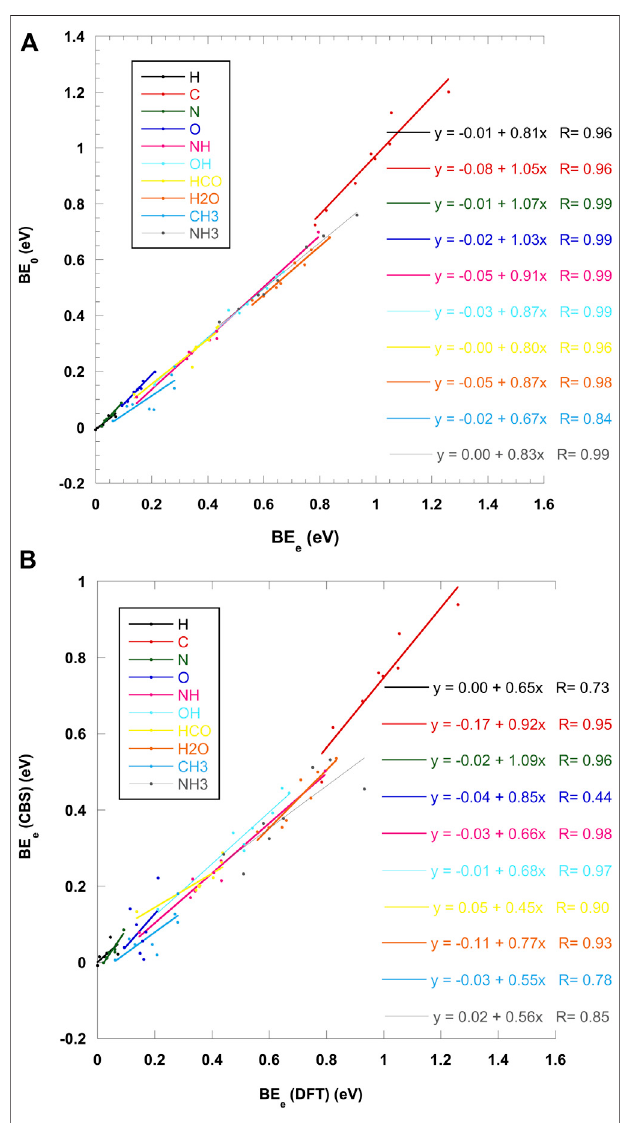
FIGURE 8 | Effect of scaled ZPE on ONIOM( ω B97X-D/6-31+G**:PM6) BE ’ s for crystalline ices (A) Effect of CBS single point on ZPE-corrected BE ’ s for crystalline ices (B)